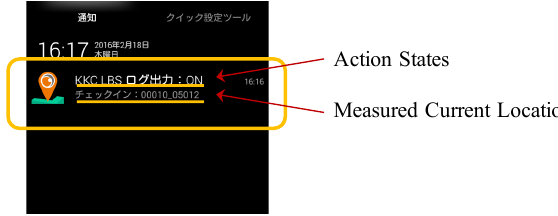
Figure 3. Smartphone application screenshot